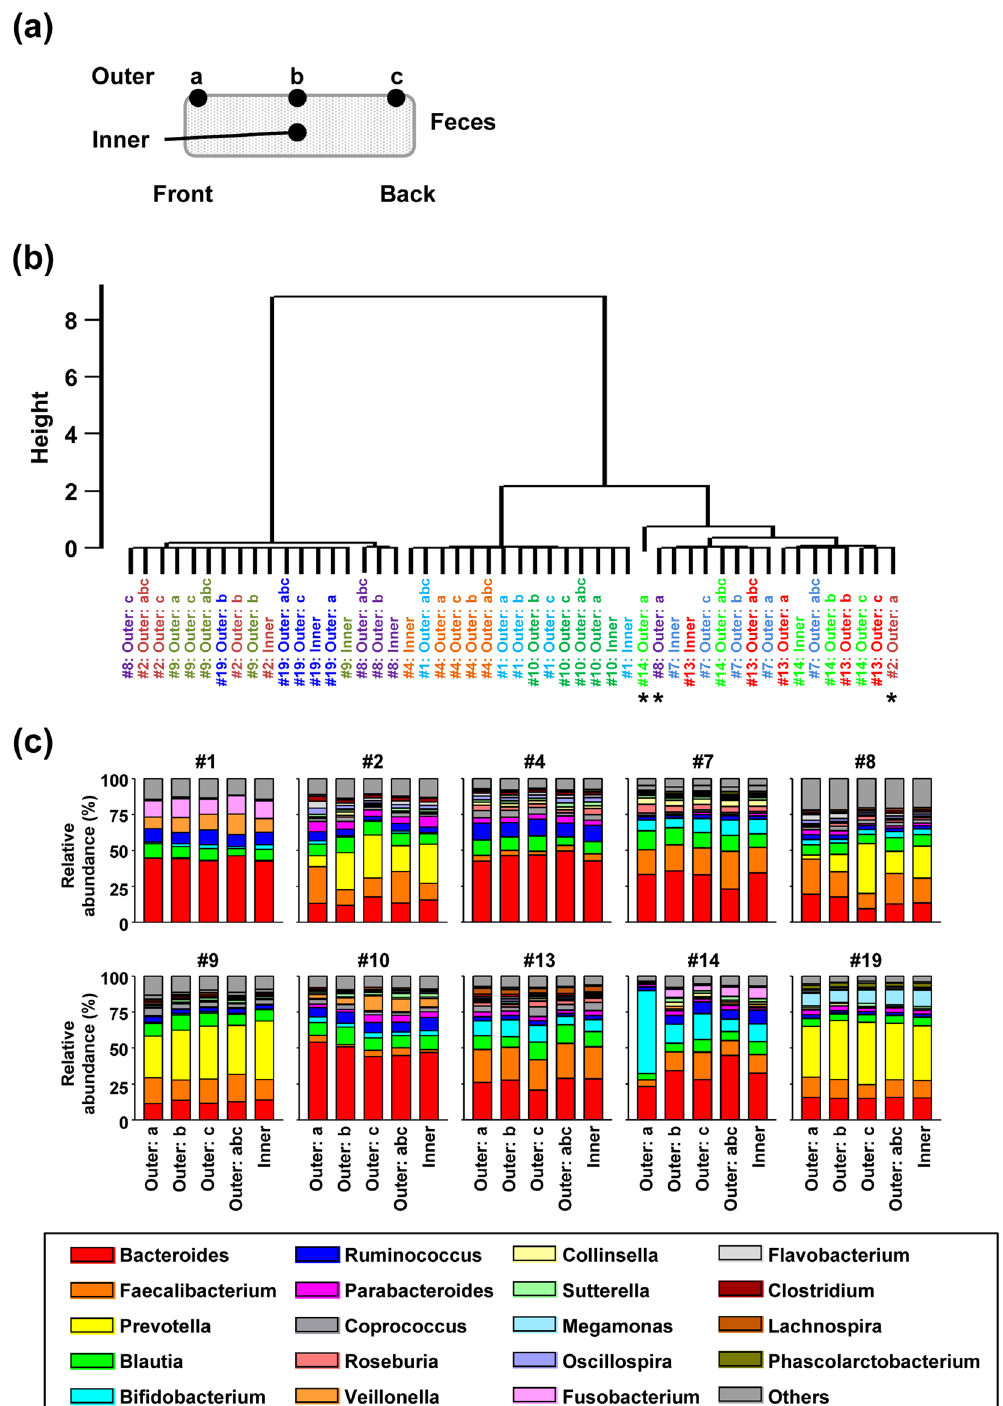
Figure 6. Comparison of the microbial composition at different positions in fecal samples. ( a ) Schematic diagram showing fecal sampling position. Subsamples were collected from different positions (outer or inner layer; front, middle, or back) in the feces. ( b ) Phylogenetic tree based on the microbial composition at the genus level. Samples collected from the same individual are indicated by the same color. The height represents relative genetic distance. The asterisks indicate samples that were clustered far from other samples collected from the same individual. ( c ) Microbial composition at genus level of different positions in feces from 10